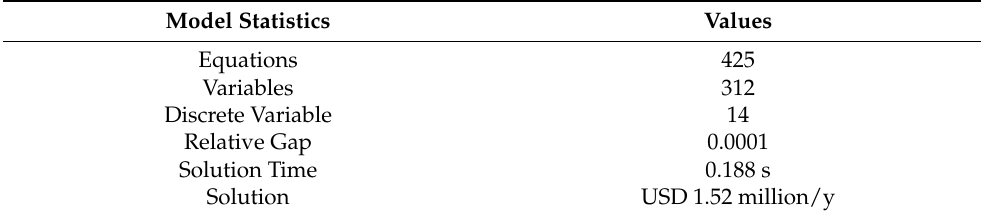
Table 3. GAMS summary statistics for municipal WW case